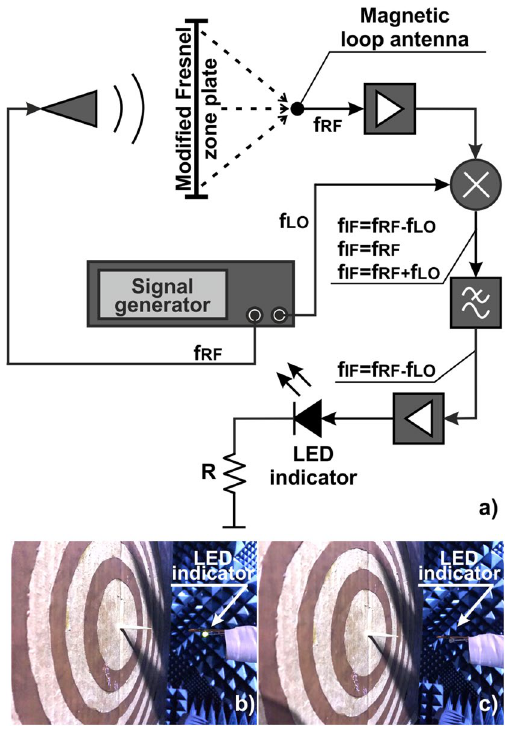
Figure 10. DoA—electro-optical detection. The LED indicator lights up at a focal spot, mapping the angle of incidence to the Fourier plane of the lens. ( a ) Signal amplification scheme, ( b ) light ‘on’—detection; ( c ) light ‘off’—displaced